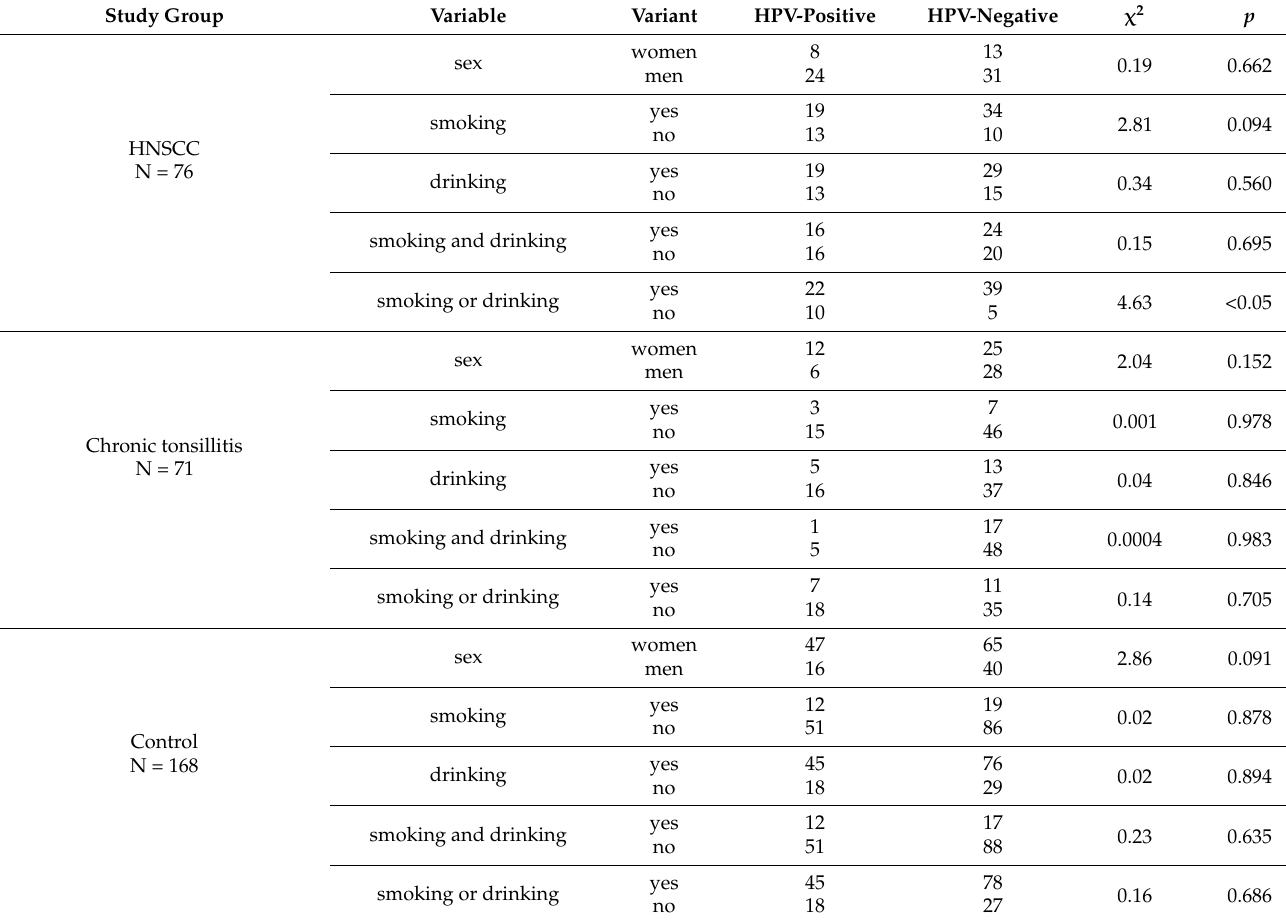
Table 4. Analysis of demographic variables in study groups depending on the occurrence of HPV. Statistical significance ( p ) was calculated by the χ 2